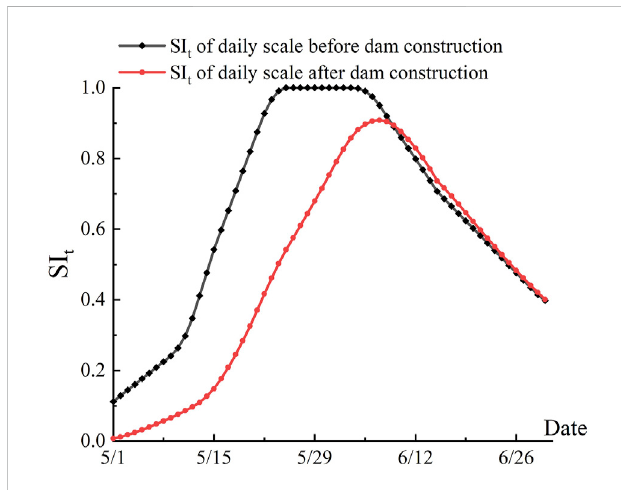
FIGURE 8 Comparison of the daily-scale water temperature index ( SI t ) of the Yellow River carp before and after dam